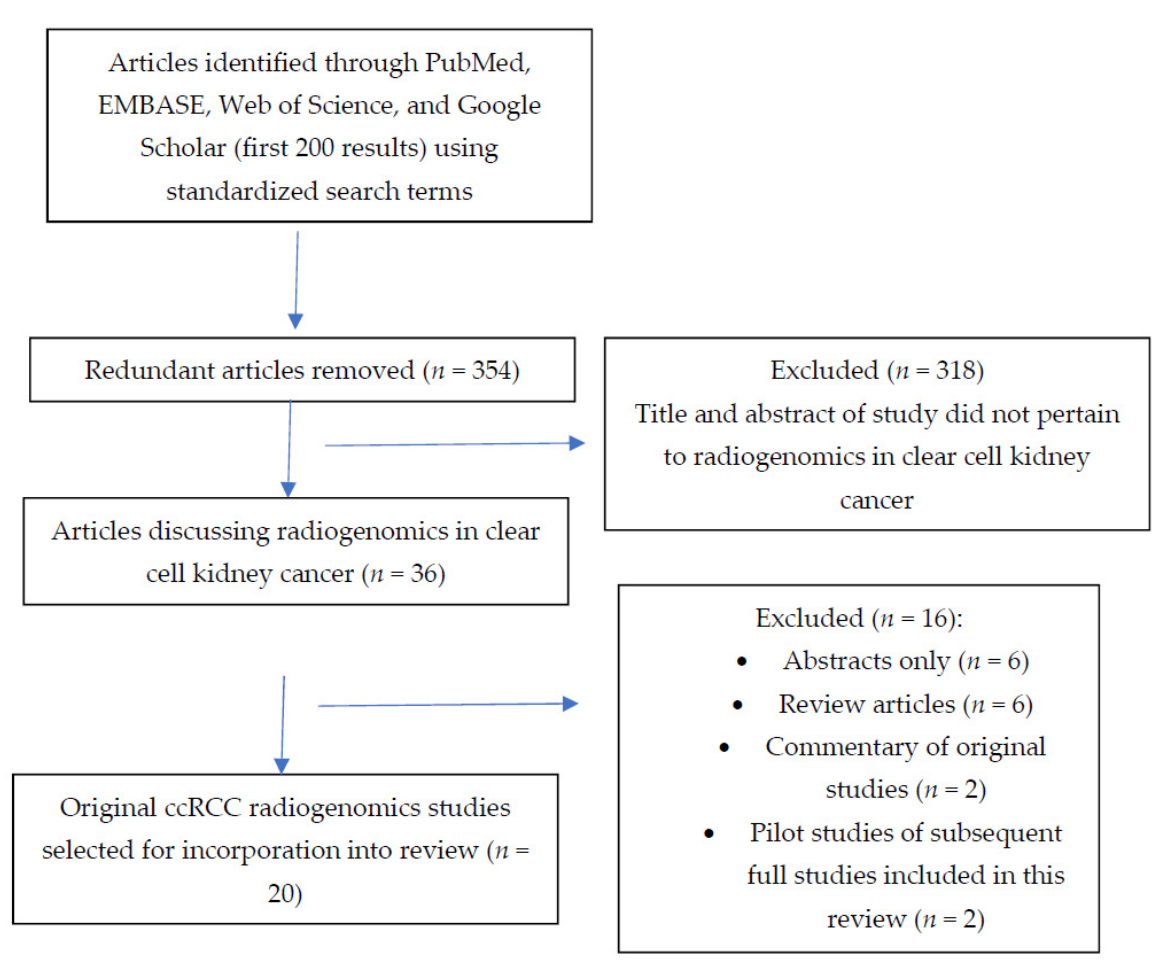
Figure 2. Flowchart demonstrating the search strategy and selection criteria for the articles included in this review. Table 1. Summary of 20 reviewed articles on radiogenomics in clear cell renal cell carcinoma. Nature of feature extraction is indicated by “Radiologist” if features are scored by one or more radiologists. Elsewise, software derived features are indicated by “Computational”. Number of selected features indicated in parenthesis. TAT (total adipose tissue), VAT (visceral adipose tissue), AUC (area under the curve), OR (odds ratio), HR (hazard ratio), CSS (cancer specific survival), OS (overall survival), PFS (progression free survival).